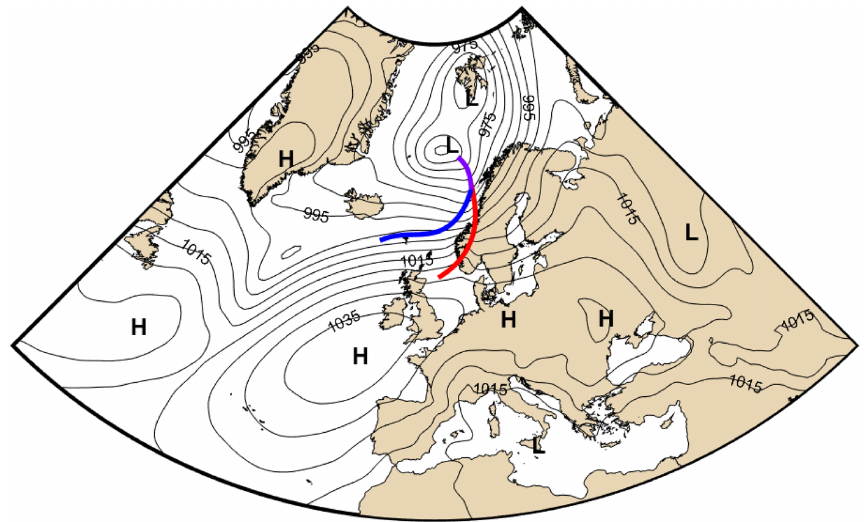
Figure 3. Mean sea level pressure (hPa) on 15 November at 12:00UTC (13:00LT, local time). Large amounts of warm and moist air blew towards the Norwegian coast because of low pressure northeast of Iceland and high pressure southwest of England. The air was close to 100% saturated with water vapor, which precipitated as the air cooled when it rose over the mountains in western Norway. The red line indicates the position of the warm front, and the blue line is the cold front. The warm air sector lies between the red and blue lines. The purple line indicates an occluded front, which means that the cold front has caught up with the warm front. Table 1. Information of the landslides shown in Fig. 2a, b and c. Figure Location Date Time Top End Length Mean Comment (hour, LT) altitude altitude of slide